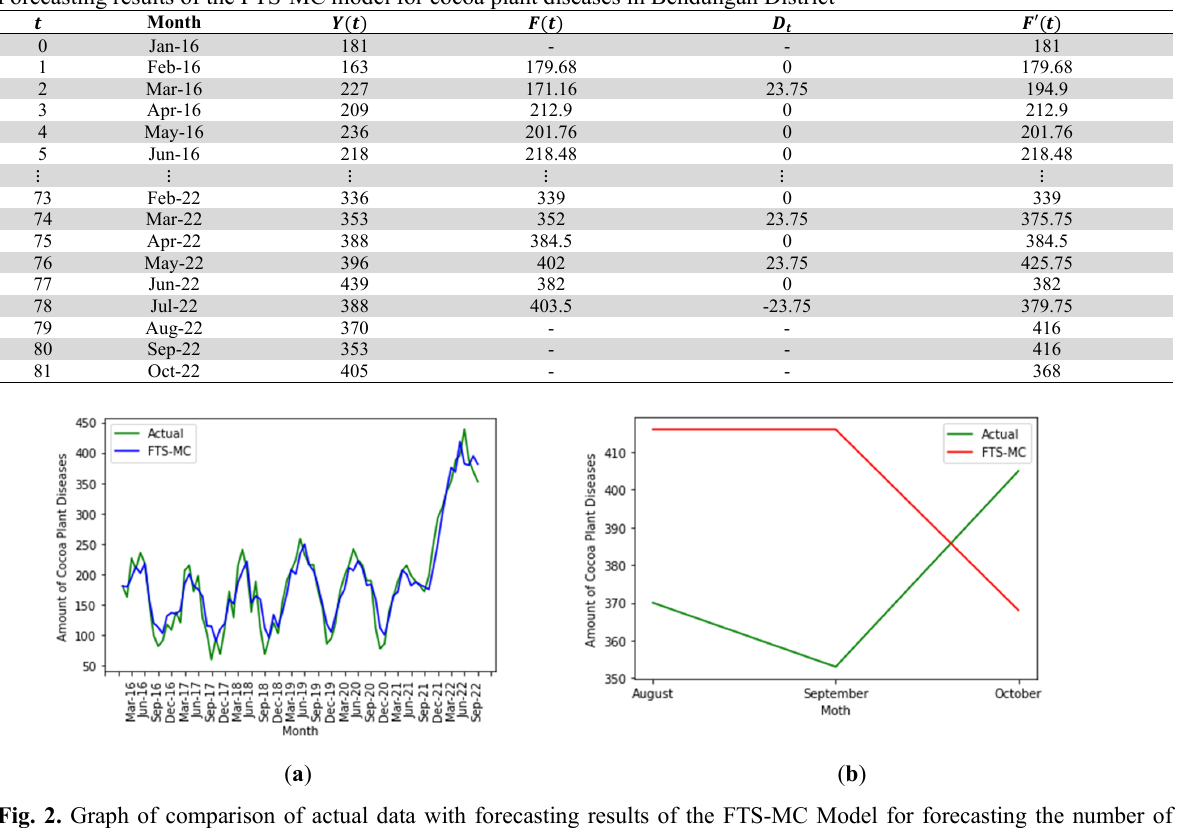
Forecasting results of the FTS-MC model for cocoa plant diseases in Bendungan District